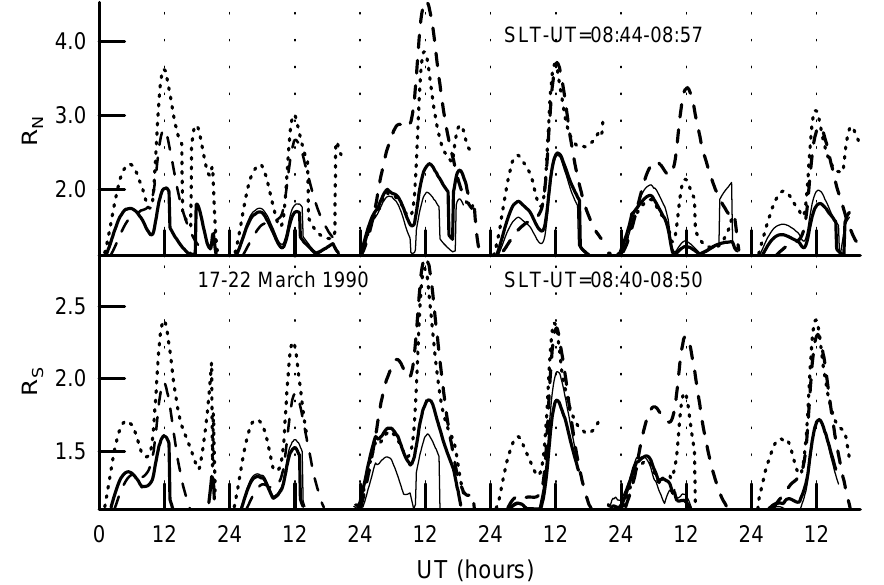
Fig. 11. The calculated crest-to-trough ratios in the northern (top panel) and southern (bottom panel) geomagnetic hemispheres during 17–22 March 1990. The heavy solid curves show the results obtained from the model of the ionosphere and plasmasphere, using the combinations of E eff , based on the corrected zonal electric field given by the solid line in Fig. 2, the corrected NRLMSISE-00 neutral 3 densities, and the corrected meridional wind. The dashed lines show the results produced by the model, using the combinations of E eff based on the corrected zonal electric field given by the solid lines in Fig. 2, zero neutral wind, and the NRLMSISE-00 neutral densities with the same corrections as for the heavy solid lines. The dotted lines show the results produced by the model, using the combinations of the E eff based on the geomagnetically quiet equatorial zonal electric field found from the empirical model of Scherliess and Fejer (1999) (dotted line in the bottom panel of Fig. 2), the HWM90 wind velocities with the same corrections as for the heavy solid lines, and the NRLMSISE-00 neutral densities with the same corrections as for the heavy solid lines. The thin solid lines show the results produced by the model using the same values of the zonal electric field and the neutral HWM90 wind as for the solid lines in Figs. 3–6, while neutral densities and temperature are taken from the NRLMSISE-00 model for hypothetical geomagnetically quiet conditions (seven 3-h geomagnetic indexes Ap are equal to 1), using the [N 2 ] and [O 2 ] correction factor found for the quiet day of 17 March for 17–22 March. The same values of a number of a given day and solar activity indexes as for the model results shown by the heavy solid, dashed and dotted lines are employed for the thin solid line. The differences between SLT and UT are 08:40–08:50 and 08:44–08:57 for model calculations of R S and R N ,